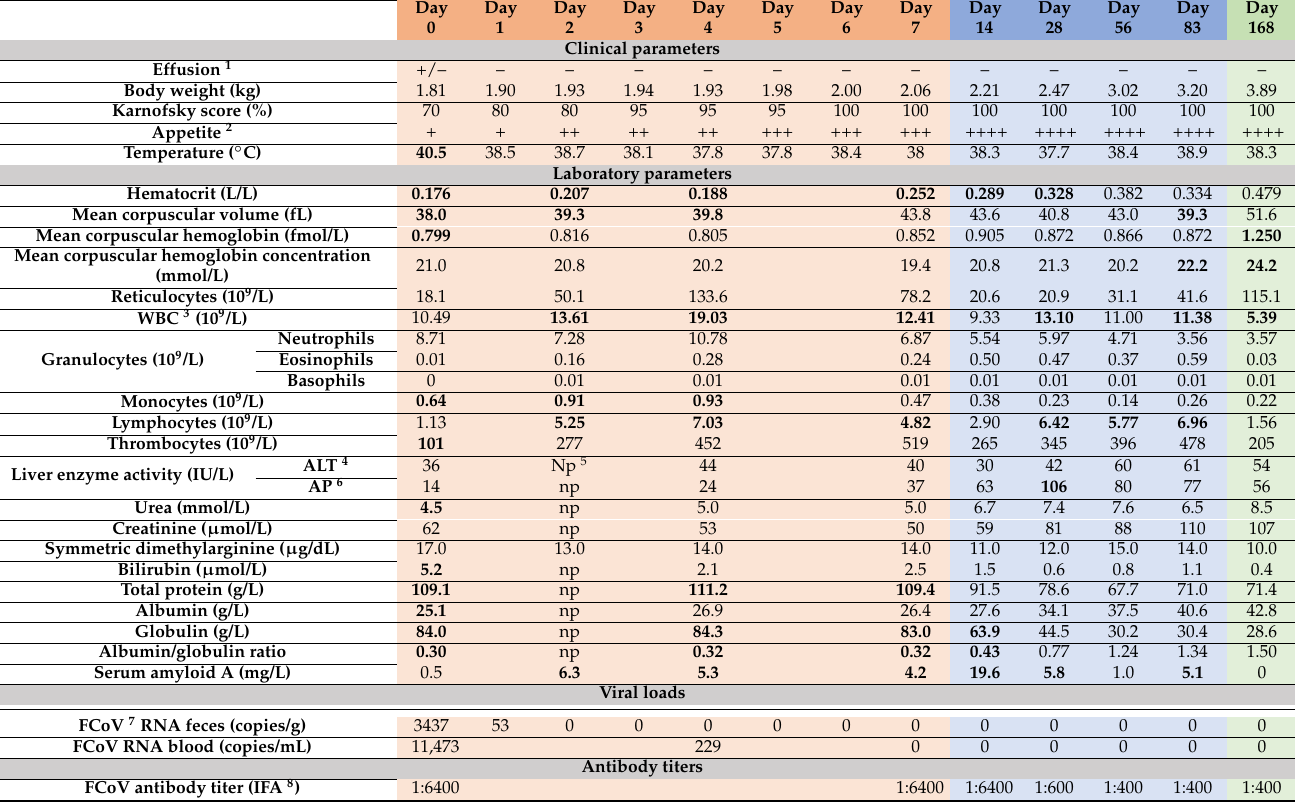
Table 2. Physical examination and laboratory parameters of a 6-month-old cat with feline infectious peritonitis. Columns are colored according to the different study sections: orange, hospitalization in the clinic (day 0–7); blue, recheck visits during treatment (day 14, 28, 56, 83); green, follow-up period after the end of treatment. Values marked in bold are outside the reference